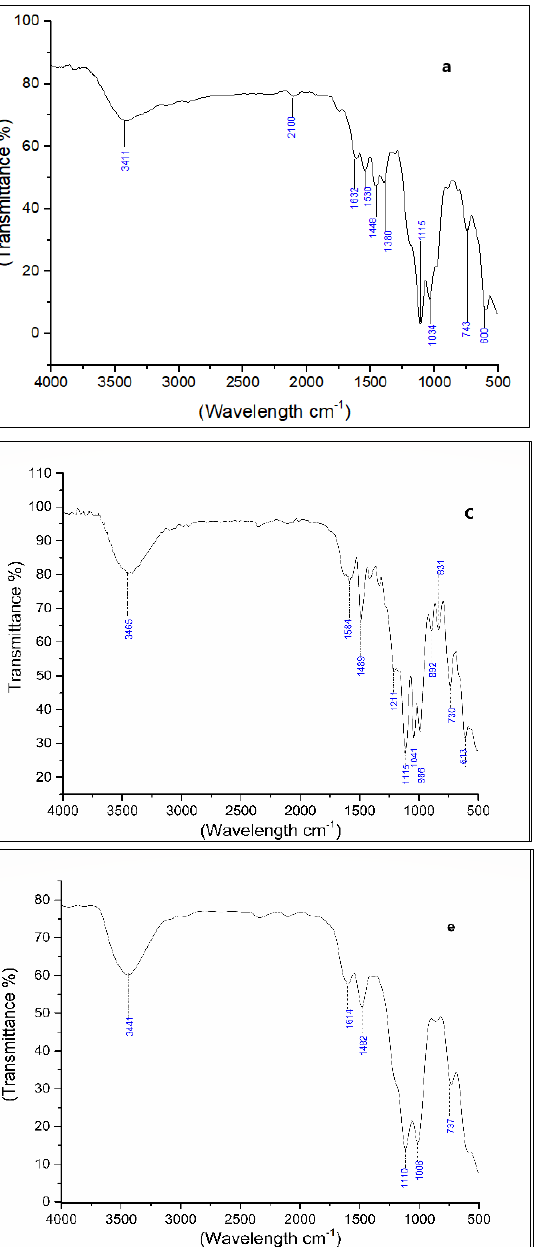
8 of 14 Figure 6. Growth curve of P. caudatum UR03 in culture medium containing azo dyes, RR2 ( a ), RB5 ( b ) and LY ( c ) at different pH values. 3.4. Degradation Products of Azo Dyes Azo dye molecules as a powder were analyzed by FTIR in the control and treated